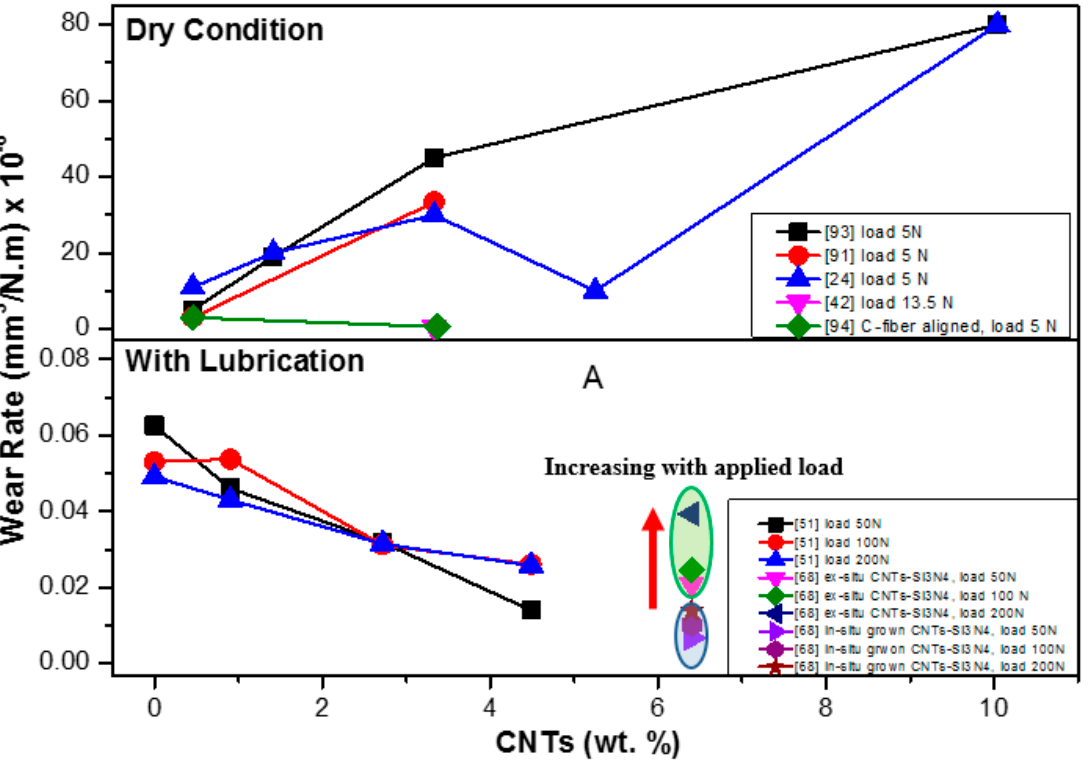
Figure 12. Influence of the CNTs addition on the wear rate of Si 3 N 4 + CNT composites reported by di ff erent researchers.